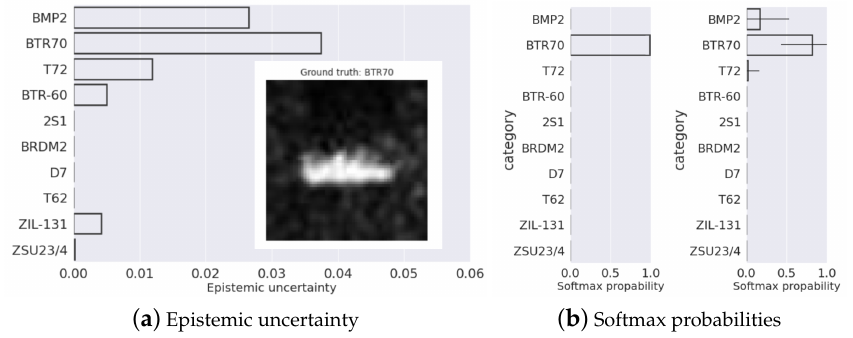
Figure 7. Comparison of CNN and BCNN predictions for in-distribution sample of a BTR70. ( a ) Epistemic uncertainty of the sample. ( b ) Softmax probability for both the CNN and BCNN. The softmax graph with error bars correspond to the BCNN. The CNN had a predicted softmax probability of